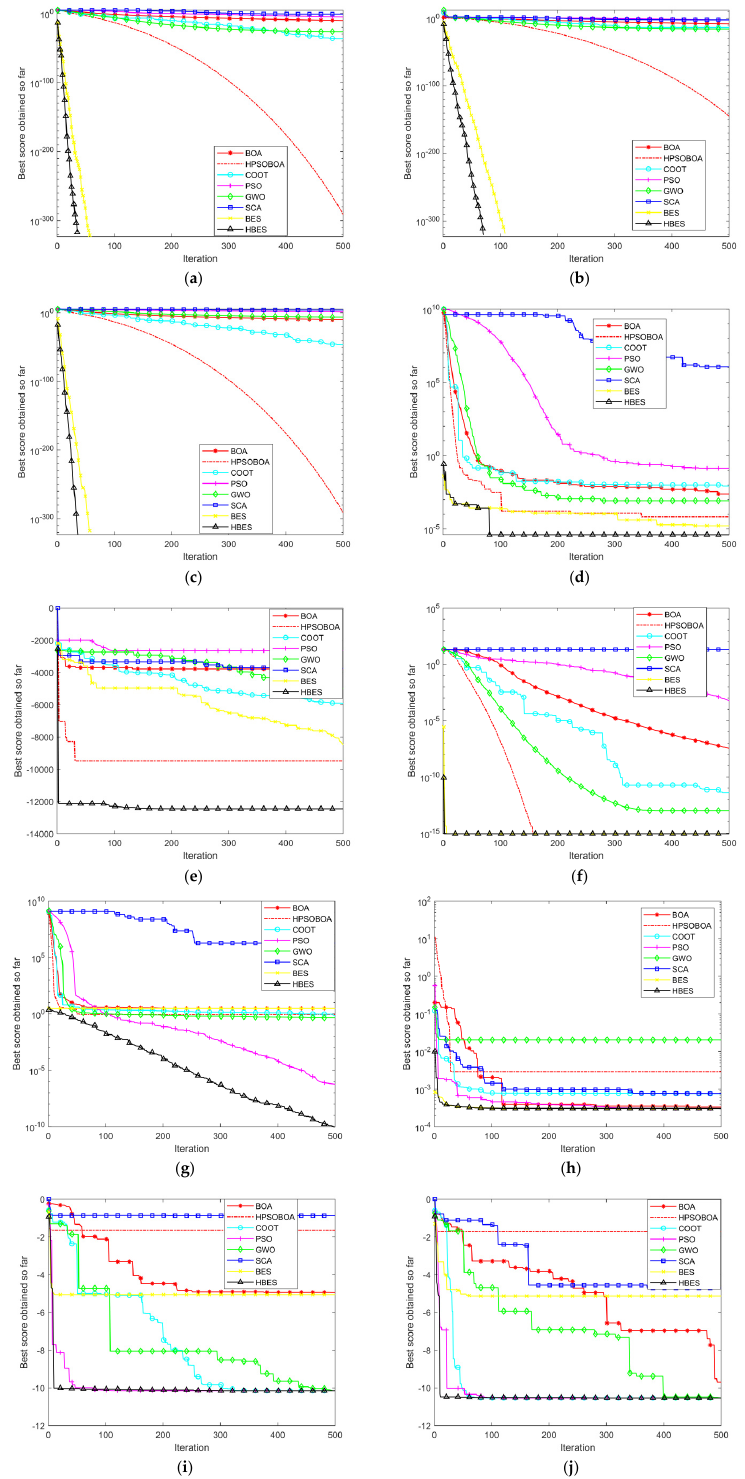
Figure 4. Simulation diagram of the test function: ( a ) comparison of convergence curves on F 1 ; ( b ) comparison of convergence curves on F 2 ; ( c ) comparison of convergence curves on F 3 ; ( d ) comparison of convergence curves on F 7 ; ( e ) comparison of convergence curves on F 8 ; ( f ) comparison of convergence curves on F 10 ; ( g ) comparison of convergence curves on F 13 ; ( h ) comparison of con- vergence curves on F 15 ; ( i ) comparison of convergence curves on F 21 ; ( j ) comparison of convergence curves on F 23